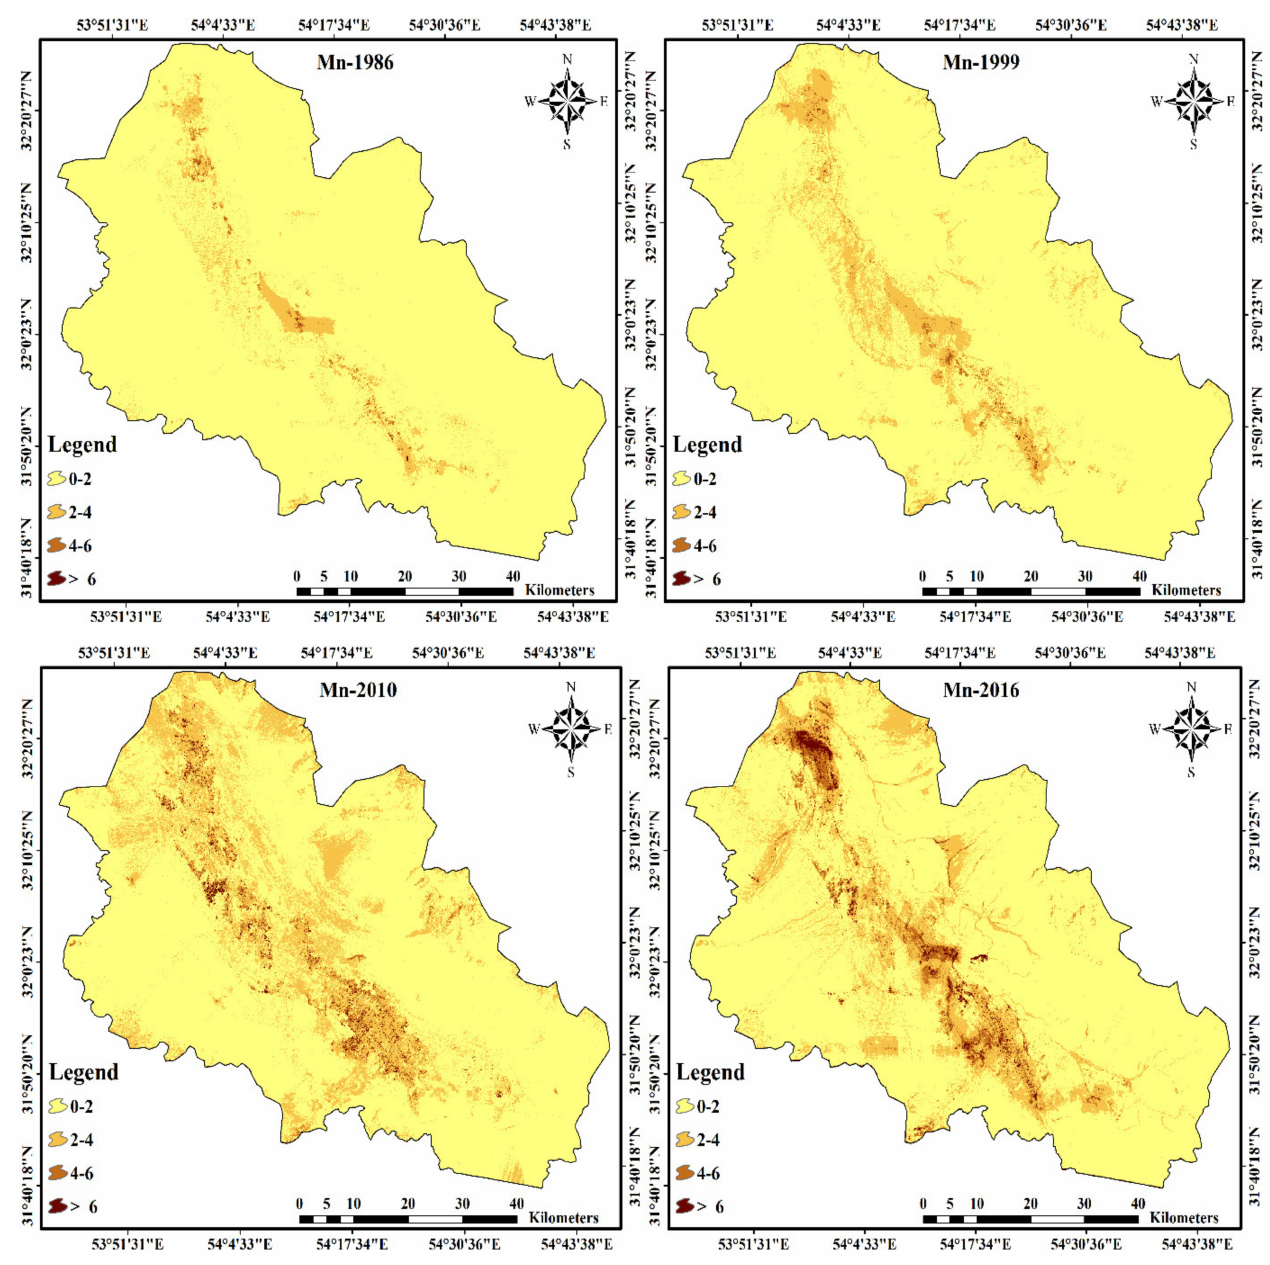
Figure 7. The spatial prediction of Mn (mg/kg − 1 ) for 1986, 1999, 2010, and